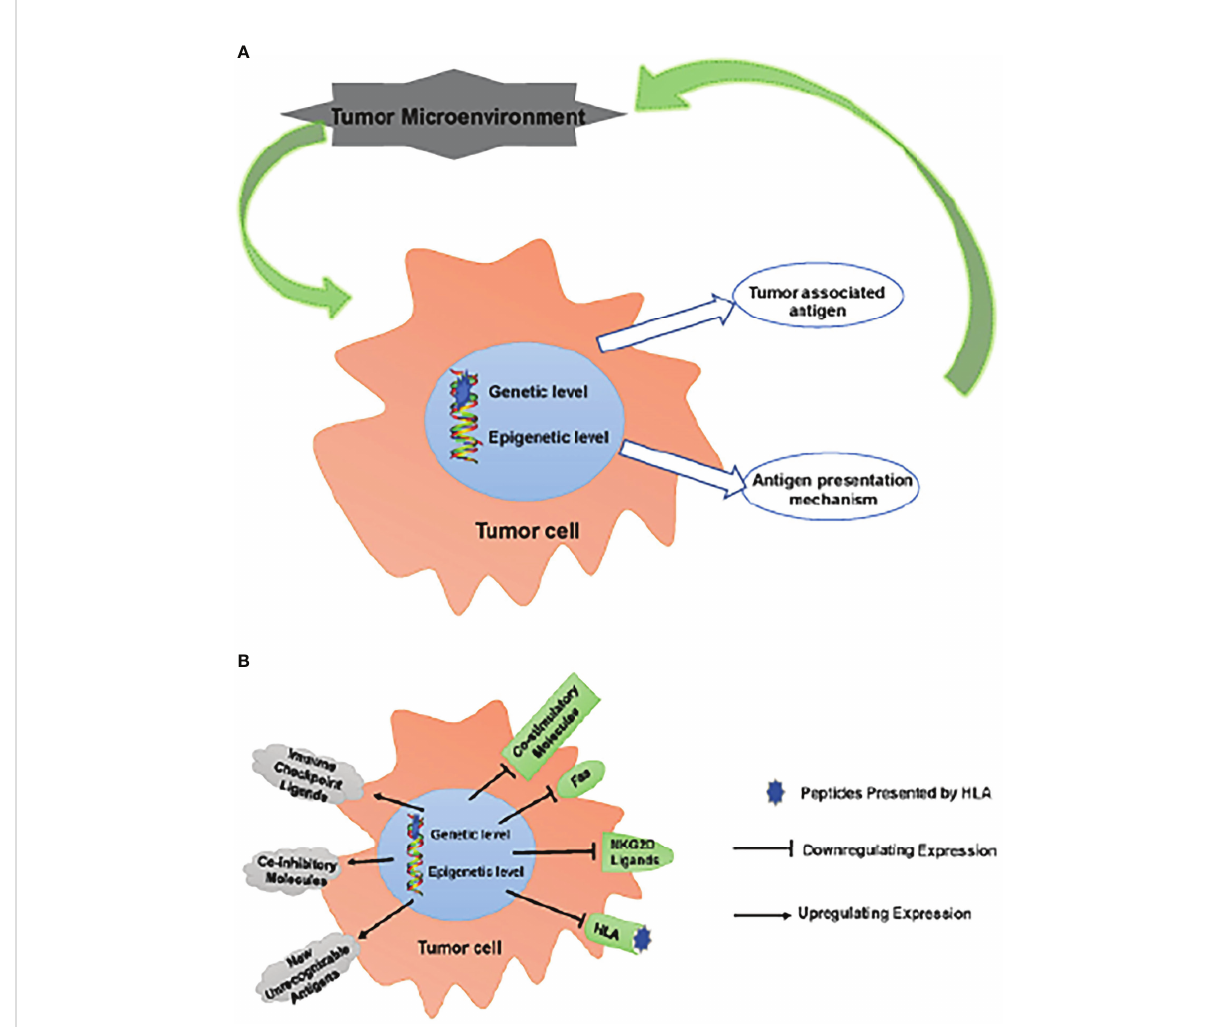
FIGURE 1 Escaping immune surveillance by changing TAA and APM. (A) Tumors have altered self-antigen expression through genetic mutations or epigenetic regulation, resulting in tumor cells escaping immune surveillance and clearance. Tumor cells that have escaped clearance survive to form an immunosuppressive microenvironment together with surrounding cells/cytokines, which further promotes tumor survival. (B) These changes up-regulate inhibitory molecules, such as ICPs (PD-1, CTLA-4, LAG-3 and TIM-3) ligands, CD44 and CD47; meanwhile, new unrecognizable antigens appear. On the other hand, the expression of co-stimulatory molecules, CD40, Fas, NKG2D ligands (MICA/B, ULBPs) and HLA is down-regulated. These changes lead to the obstacle of TAA and APM, which makes tumor cells escape immune